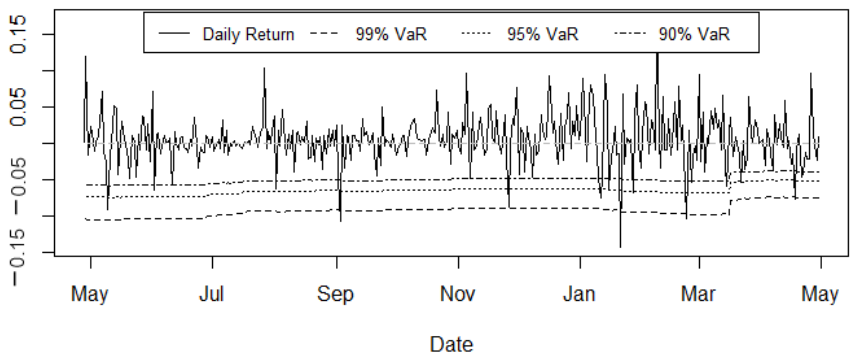
Figure 4. BTC daily return and Delta-Normal VaR.